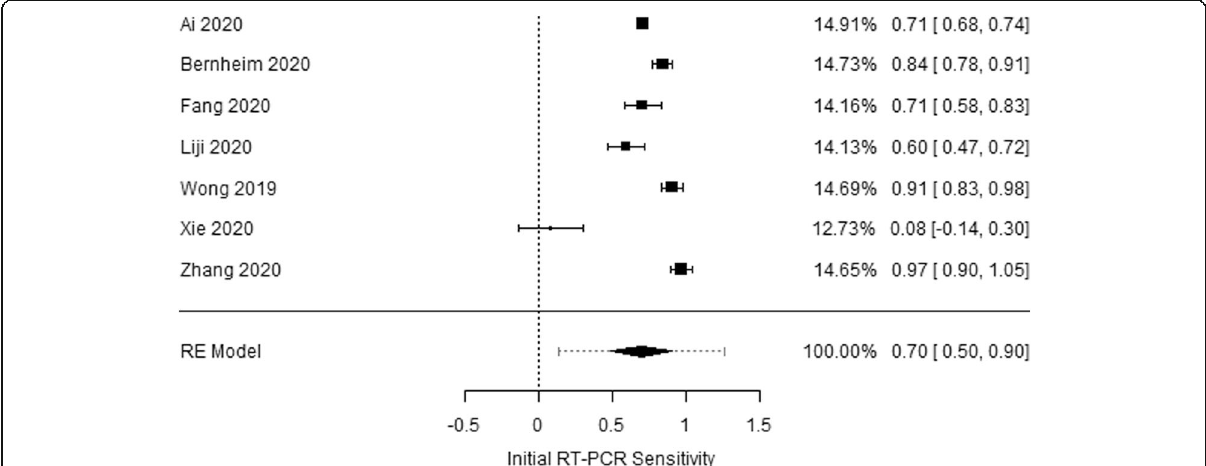
Fig. 3 Forest plot for sensitivity of initial RT-PCR. There is considerable heterogeneity across studies (Cochran Q test P value < 0.001, I -squared = 98.2%). Pooled sensitivity = 70% (95% CI = 50 to 90%). Prediction interval is presented as a dotted extension up and down the 95% confidence limits of pooled effect size [11 –